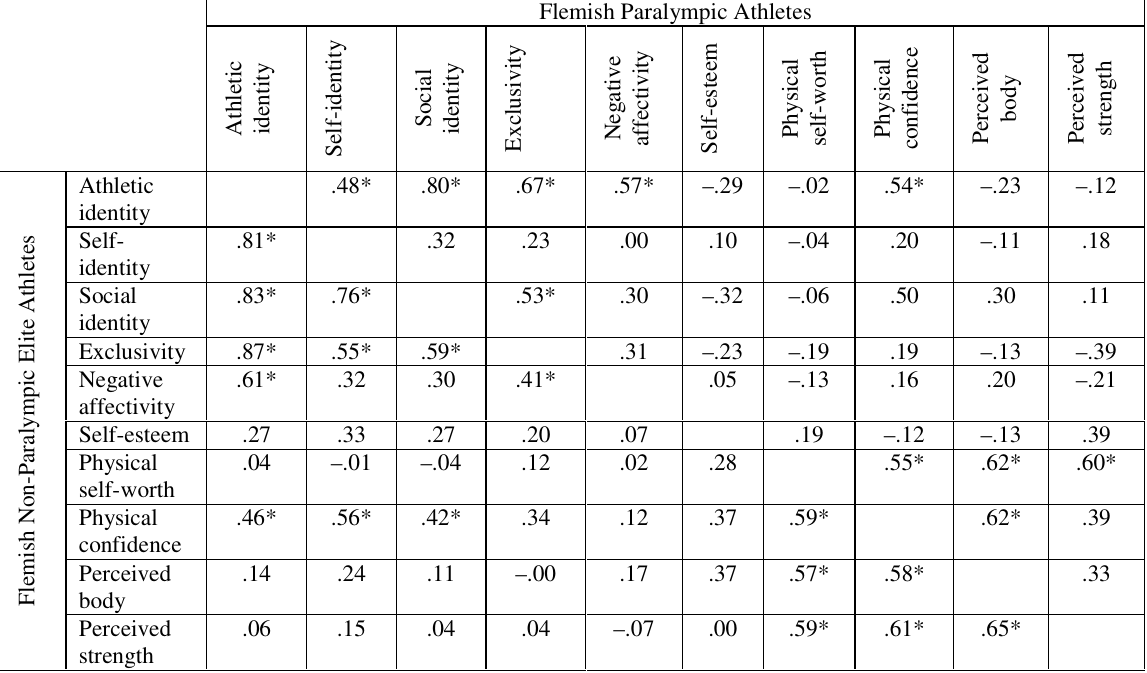
Pairwise correlations between atletic identity, global self-esteem and physical self-perceptions in Flemish Paralympic athletes (upper right part of the table) and Flemish Elite athletes (bottom left part of the table) [comparisons made at time 1, 11 months prior to Paralympic Games] Flemish Paralympic